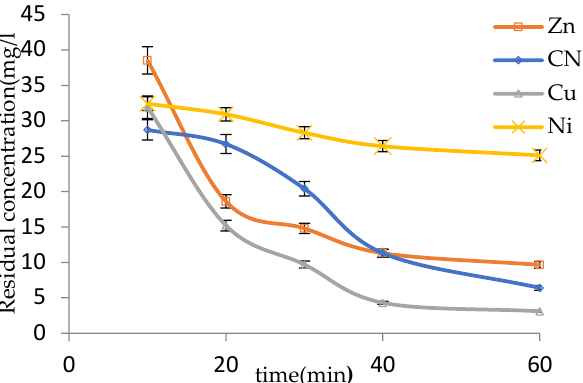
Figure 10. The effect of (PECHp) process for simultaneous removal of pollution. The highest removal efficiencies of nickel, cyanide, zinc, and copper were 85, 96.7, 94.2, and 98% at pH 10 after 60 min of photo-electrocoagulation-oxidation process. Hydroxyl radicals are produced with the onset of the reaction and UV irradiation according to Equation (29). Based on Equations (30) and (31), by applying an electric current and the oxidation of iron anode, ferrous ions are produced, which react with hydrogen peroxide to form ferric and hydroxyl ions. Some of the ferric ions produced react with hydroxides to form coagulants, and some other ferric ions are reduced by UV radiation and converted to Fe 2+ ions. The formed iron hydroxides adsorb the pollutants in the effluent and then precipitate. 2 H 2 O + hv